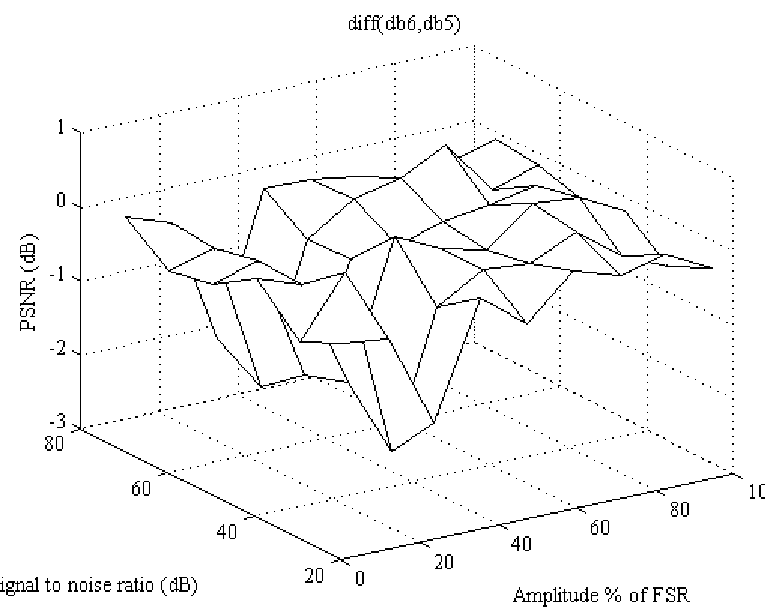
Figure 4. PSNR difference between db6 and db5.